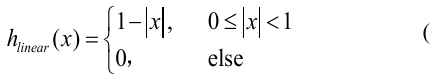
Figure 2. a) Interpolation kernels and b) frequency responses of various interpolation algorithms compared with sinc